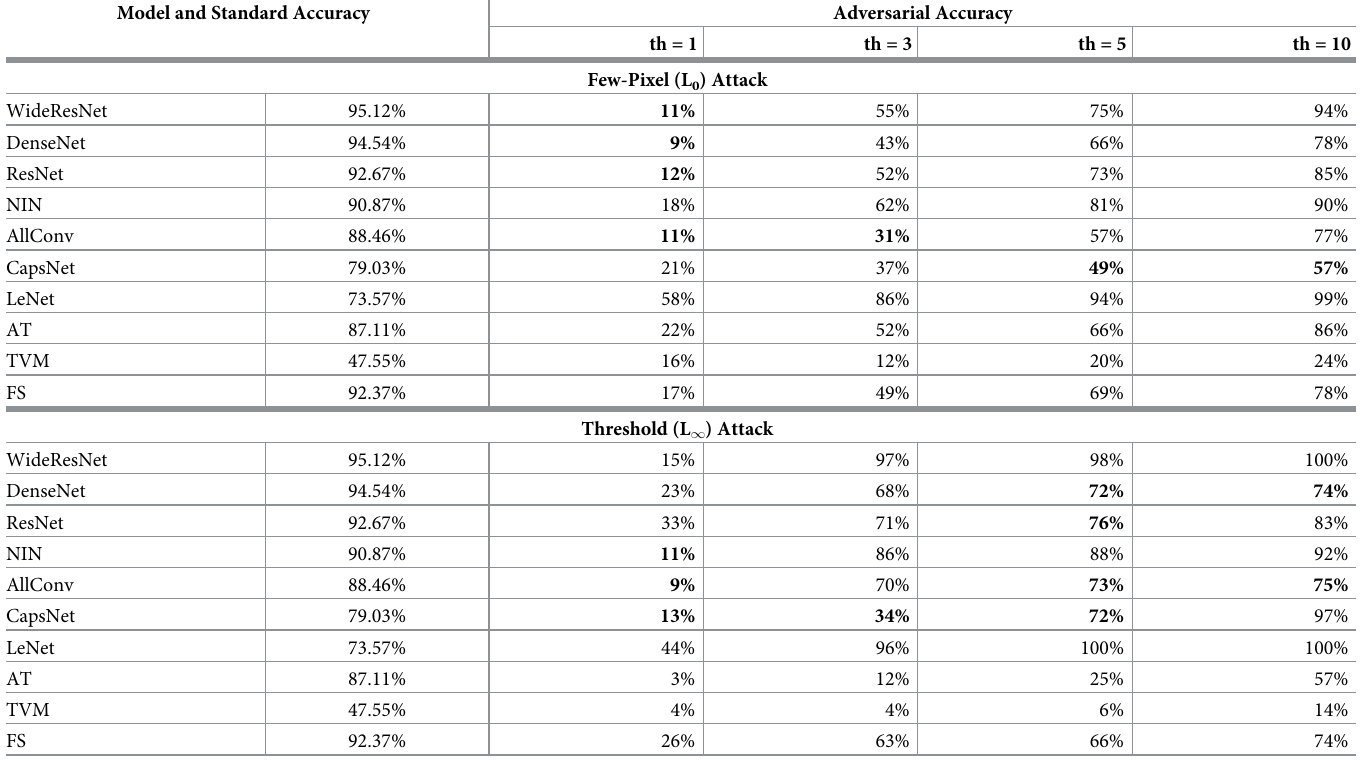
Table 5. Adversarial accuracy results for L 0 and L 1 attacks over 100 random